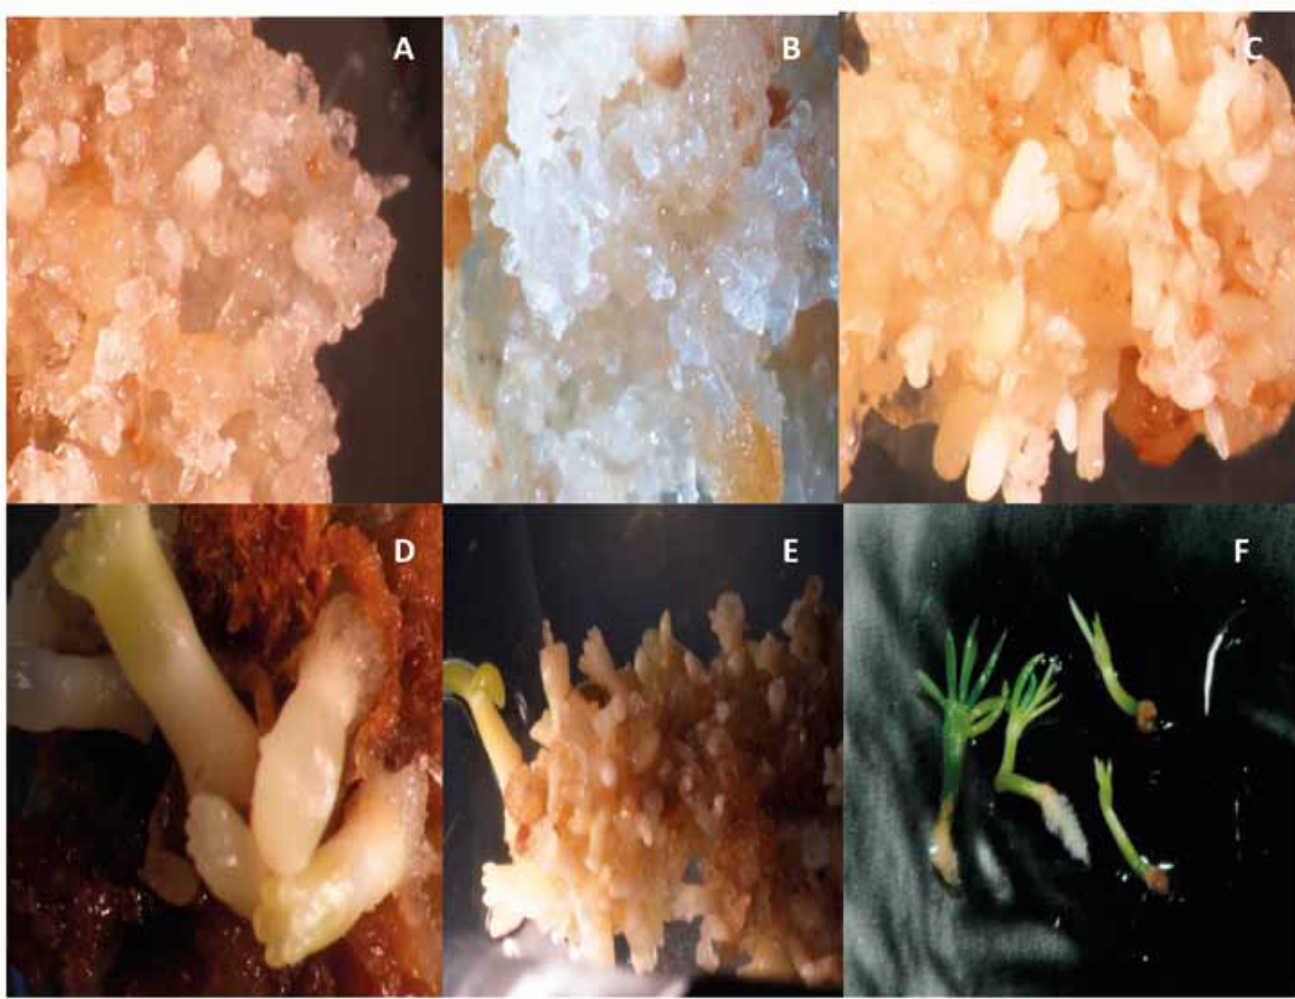
Fig. 3 - Somatic embryogenesis from mature zygotic embryos of Picea abies ; proliferation of embryogenic tissues (A and B); maturation (C-E) and germination (F) of somatic